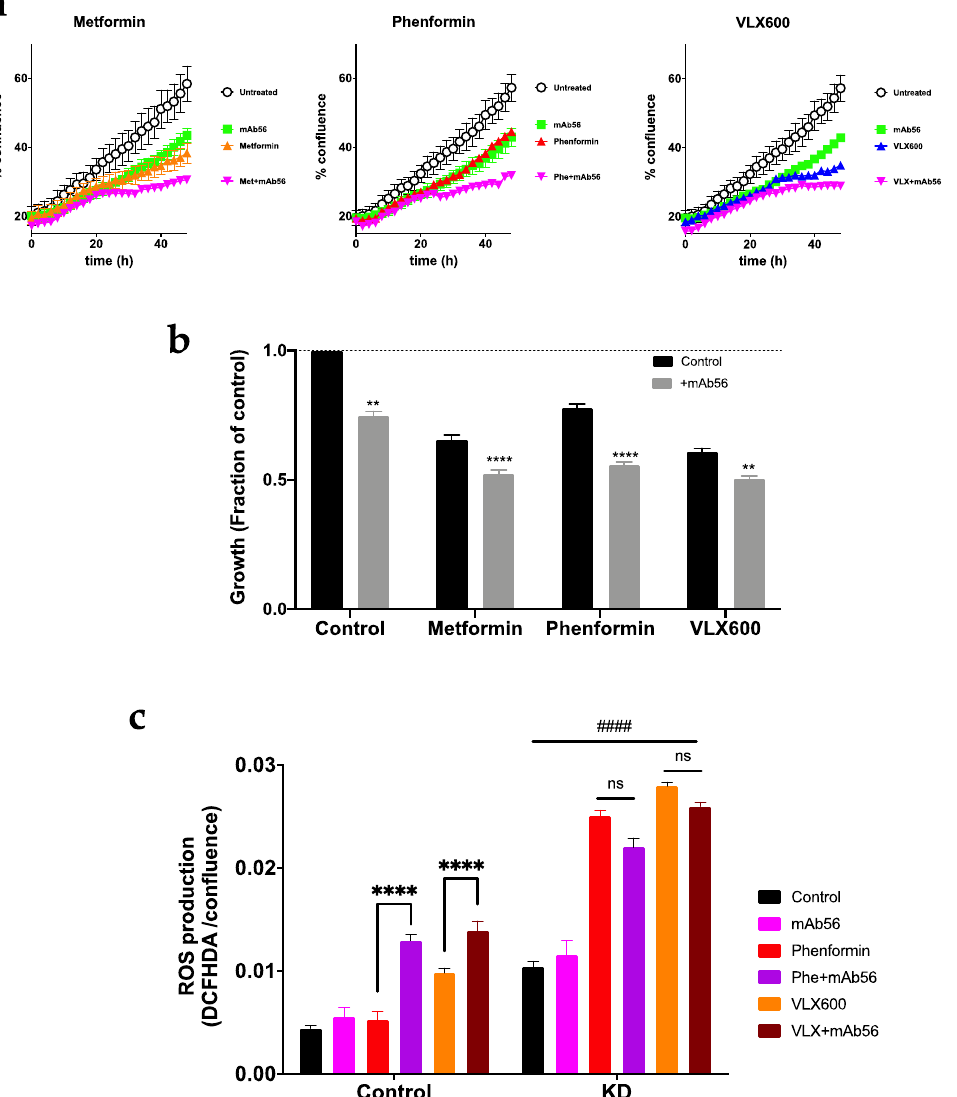
Figure 10. Combined treatment using metabolic inhibitors and mAb56 show higher efficacy than monotherapy. ( a ) Growth of HeLa cells treated with metformin (5 mM), phenoformin (100 µM) and VLX600 (100 nM) alone or in combination with an antibody specific for Kv10.1, mAb56 (10 µg/mL). Confluence was measured by phase contrast every two hours for 48 h. ( b ) Comparison of growth at the endpoint of the experiment. ( c ) ROS production was measured after 48 h of treatment using DCFHDA fluorescence. The values were normalized by the confluence in each well, as an estimation of the total number of cells. Bars represent the mean ± SEM of three independent experiments (** p < 0.01; **** p < 0.0001, two-way ANOVA). In C, #### indicates p < 0.0001 for each condition compared to the respective controls.